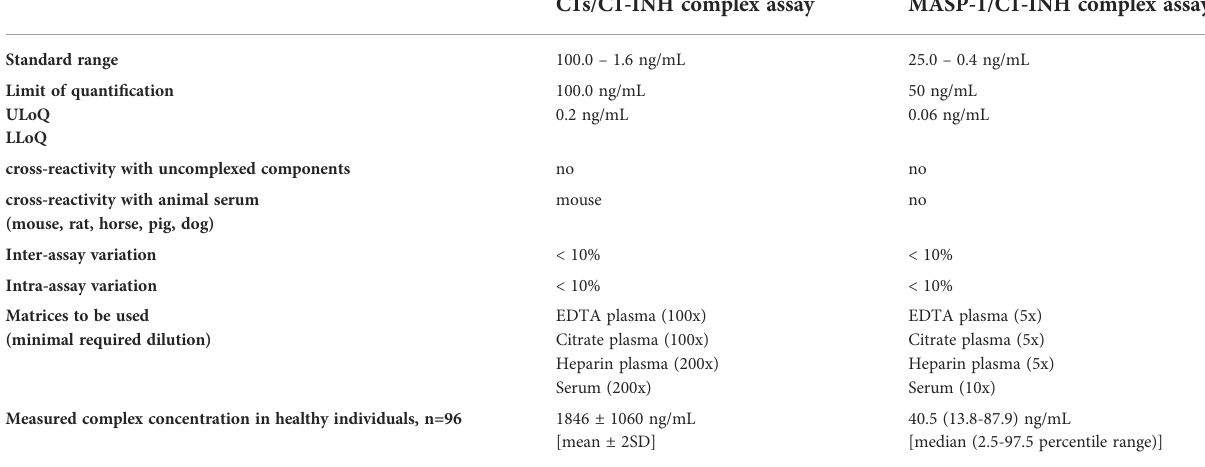
TABLE 4 Summarized characteristics of newly developed C1-INH complex